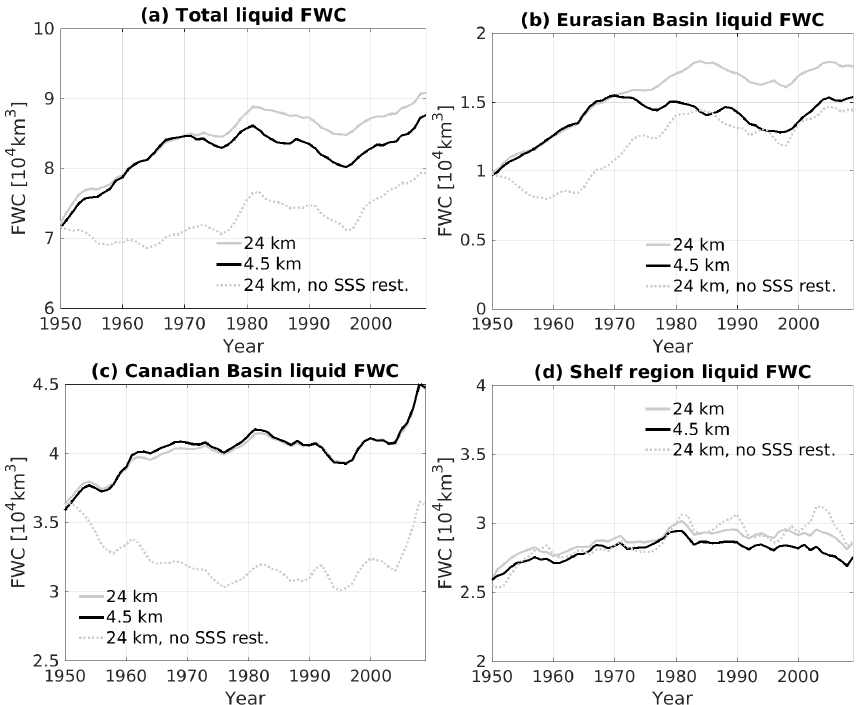
Figure 9. (a) Time series of annual mean total Arctic liquid FW content. The liquid FW content in the Eurasian Basin, Canadian Basin, and shelf regions is shown in panels (b) – (d) , respectively. The FW content is calculated using a reference salinity of 34.8. The whole integration period of 1950–2009 is